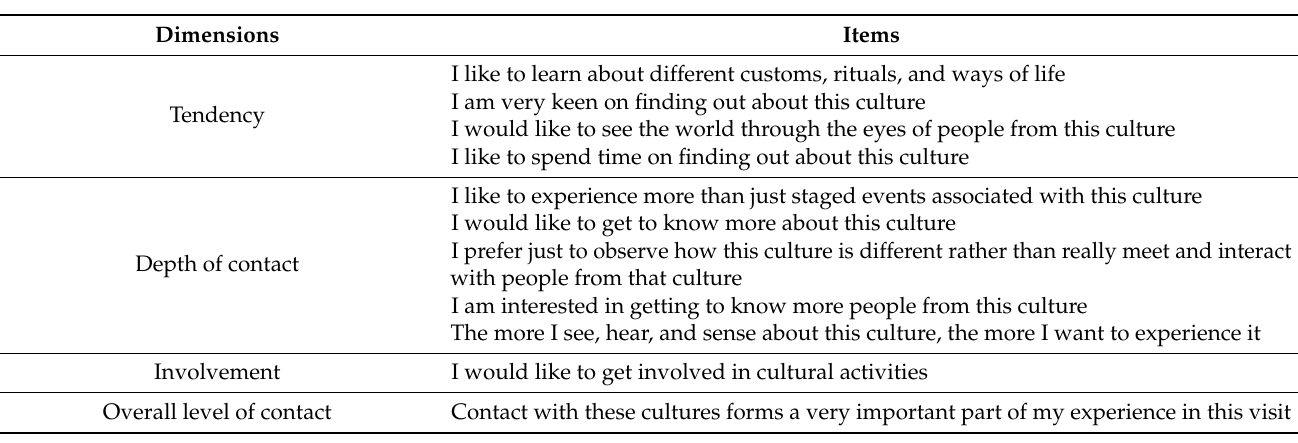
Table 1. Cultural Contact